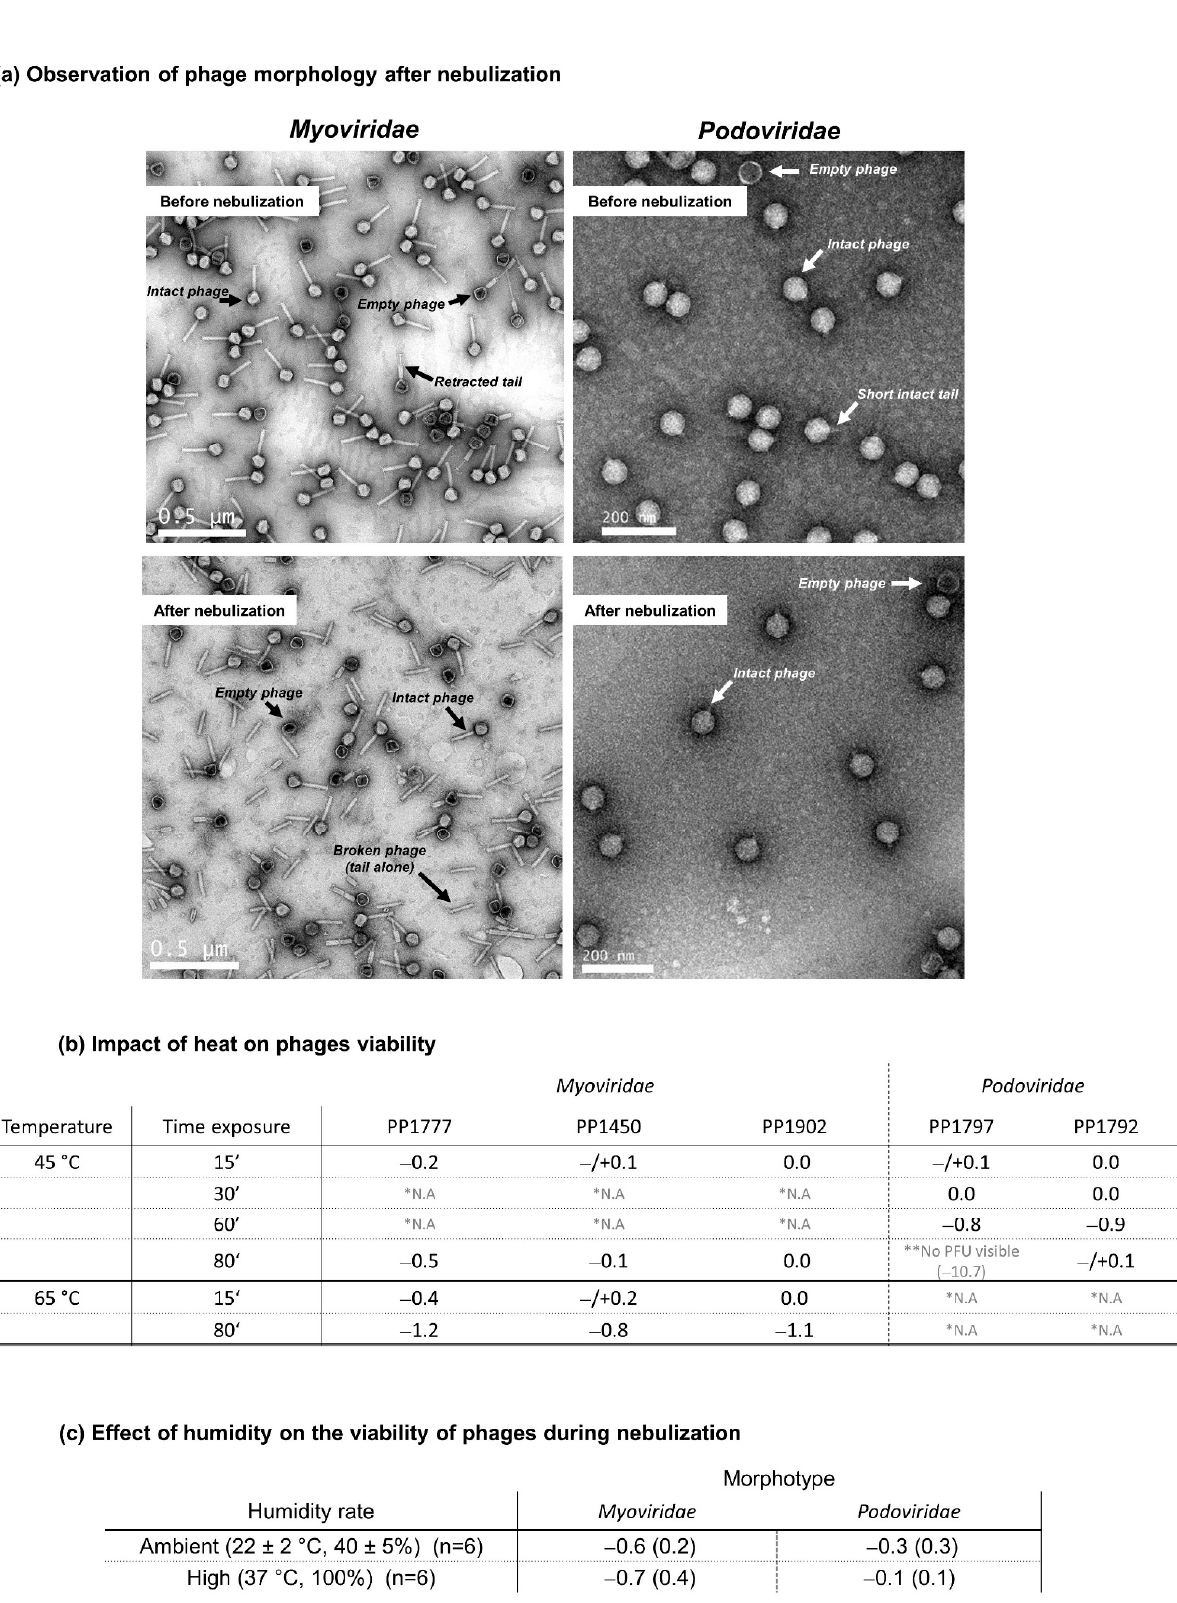
Figure 6. Impact of nebulization on phage morphology and impacts of heat and humidity during nebulization on phage viability. ( a ) Observation of phage morphology after nebulization: Representa- tive Transmission Electron Micrographs of Myoviridae and Podoviridae before and after nebulization with the prototype static-mesh nebulizer. The white scale lines correspond to 0.5 µ m for